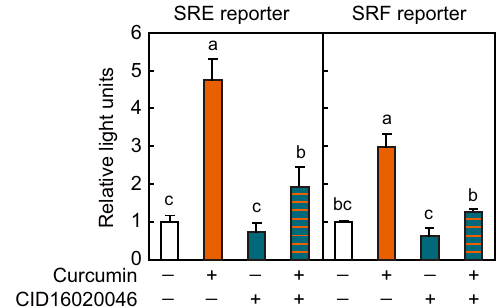
Fig. 4 Effects of GPR55 antagonists on GPR55 activation. HEK293- FT cells transfected with the GPR55 expression vector, p3xSRE-TATA- Luc2P or p2xSRF-TATA-Luc2P, and pGL4.74[ hRluc /TK] were stimu- lated with 10 µM curcumin for 4 h, and reporter assay was performed. Cells were preincubated with GPR55 antagonist (10 µM CID16020046) or vehicle for 30 min before curcumin treatment. Data were expressed as the mean ± s.d. ( n = 4). Different letters indicate signi fi cant differences ( p < 0.05).